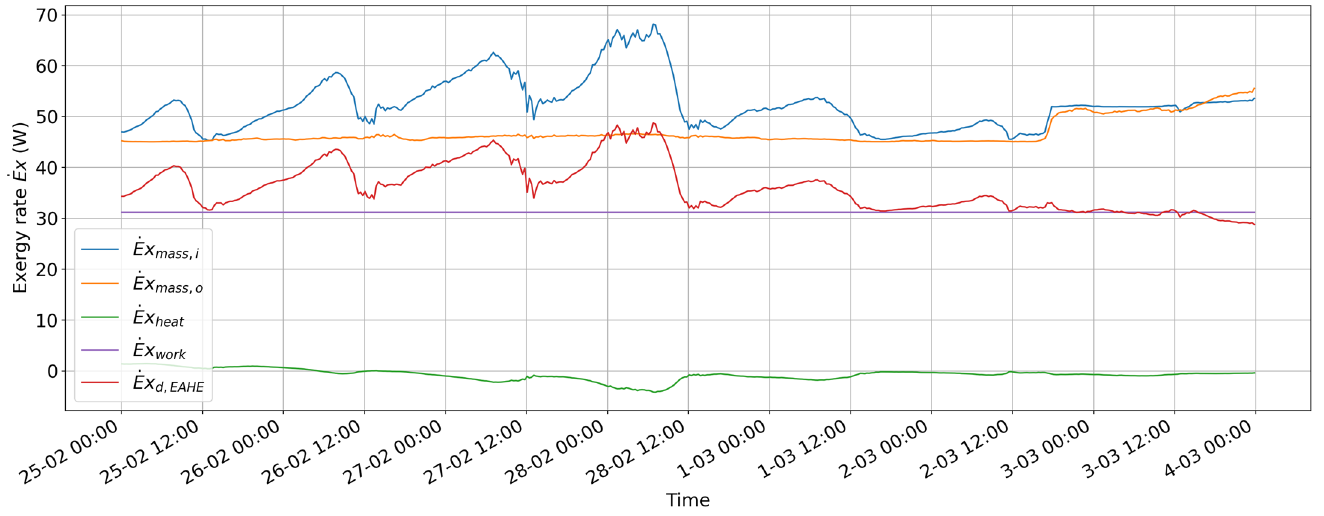
Figure 5. Exergy rates transferred to or from the system during the analysis period.